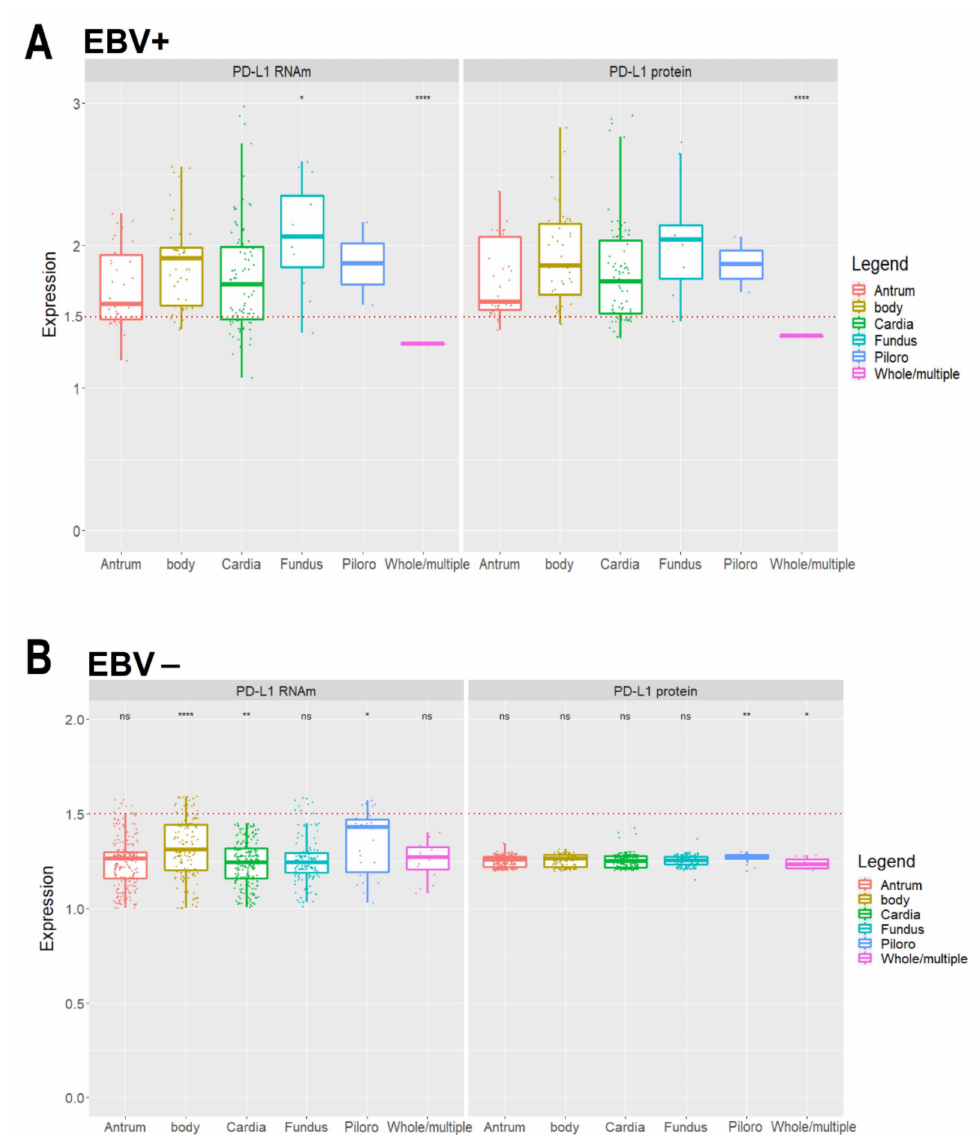
Figure 4. PD-L1 mRNA and protein levels stratified in samples obtained from different stomach locations. Levels of PD-L1 mRNA and protein in patients with EBV-positive status ( A , B ) EBV-negative status (ns, not significant, * p < 0.05, ** p < 0.01, **** p < 0.0001). The red dotted lines represent the